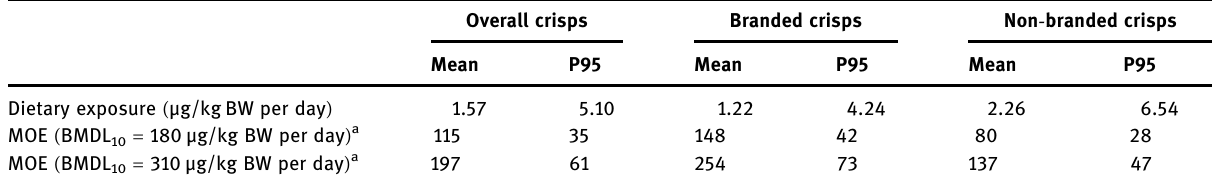
Table 3: Estimated MOE for the mean and 95th percentile of dietary exposure to acrylamide of crisps consumers in Nairobi, Kenya Overall